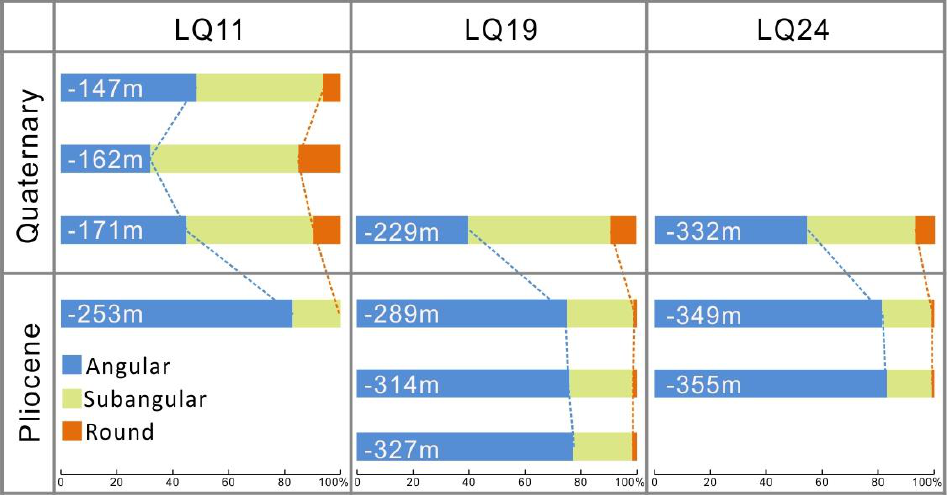
Figure 4. Features of detrital zircon roundness in the core sediment of LQ11, LQ19, and LQ24 in the Yangtze Delta.